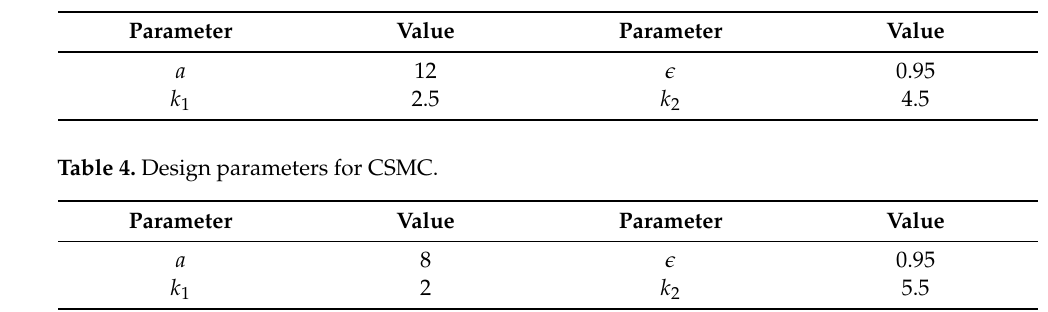
Table 3. Design parameters for SMC.